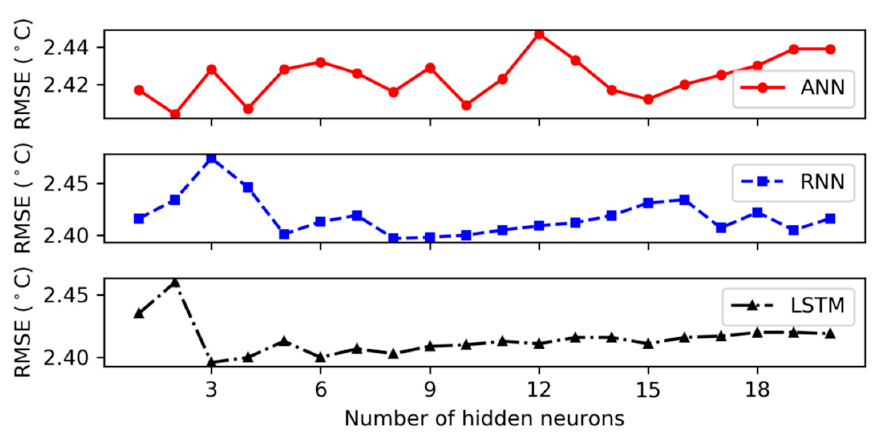
Figure 7. Root mean square error corresponding to different number of hidden neurons for 1 hidden layer in summer.